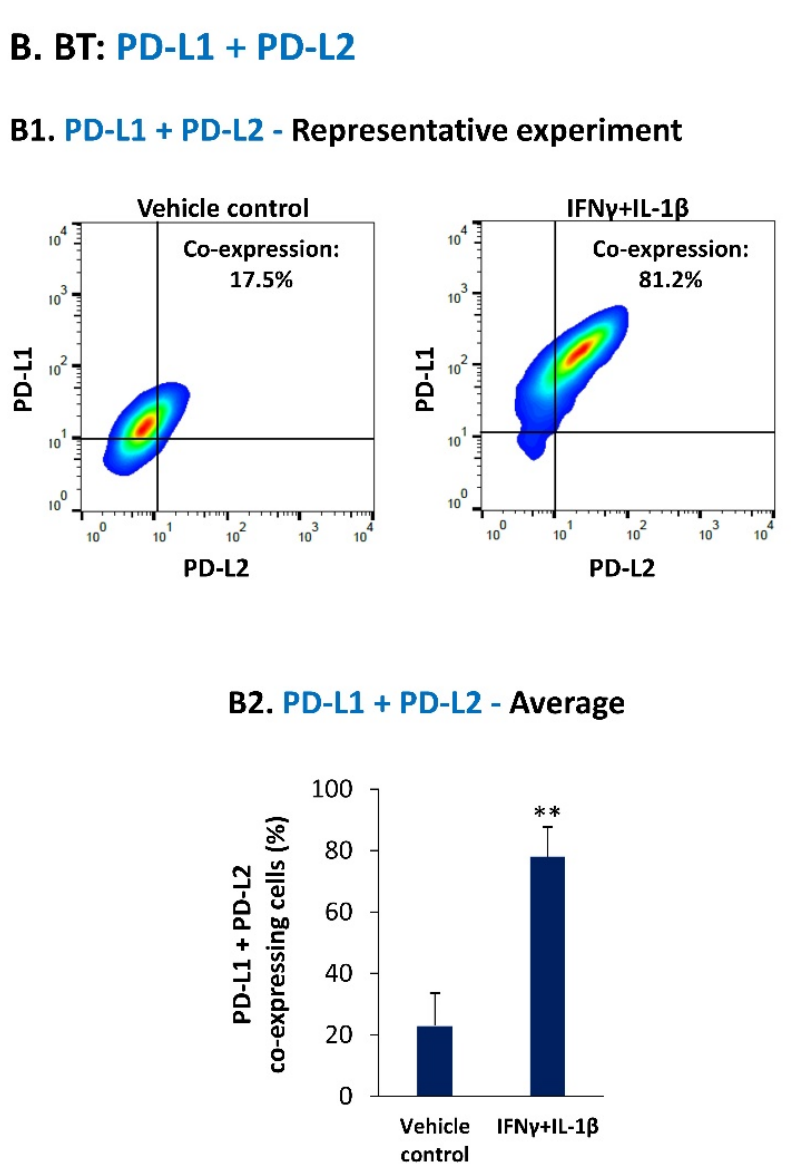
Figure 2. Joint stimulation by IFN γ + IL-1 β promotes the proportion of PD-L1 + PD-L2 co-expressing BT-549 cells. ( A ) BT-549 cells (BT) were stimulated by IFN γ and/or IL- β (IFN γ : 20 ng/mL; IL- 1 β : 500 pg/mL) for 24 h. Control cells were treated by the vehicle of the cytokines. Cytokine concentrations were selected as described in Section 2. Cell surface expression of PD-L1 ( A1 ) and PD-L2 ( A2 ) was determined by flow cytometry; MFI, mean fluorescence intensity. Isotype/s, Non- relevant antibodies used as control/s. A representative experiment of n = 3 is presented. ( B ) BT cells were stimulated by IFN γ + IL-1 β or vehicle, as in Part A. The proportion of cells co-expressing PD-L1 + PD-L2 was determined by flow cytometry, as described in Figure 1B. ( B1 ) A representative experiment of n = 3 is presented. ( B2 ) Average ± SD of n = 3 experiments is presented. ** p < 0.01. Statistical analyses were performed as described in Section 2. TCGA analyses of basal-like patients ( n = 141) greatly supported the connection between the pro-inflammatory cytokines and PD-L1/PD-L2 expression (Figure 3). Very significant associations were revealed between high expression levels of TNF α , IL-1 β and IFN γ and elevated levels of PD-L1 and PD-L2. As expected in view of the major roles reported for IFN γ in inducing PD-L1 expression, the strongest correlation was between the expression levels of IFN γ and PD-L1 in the patient cohort (r = 0.794, p = 1.029 × 10 − 31 ). IFN